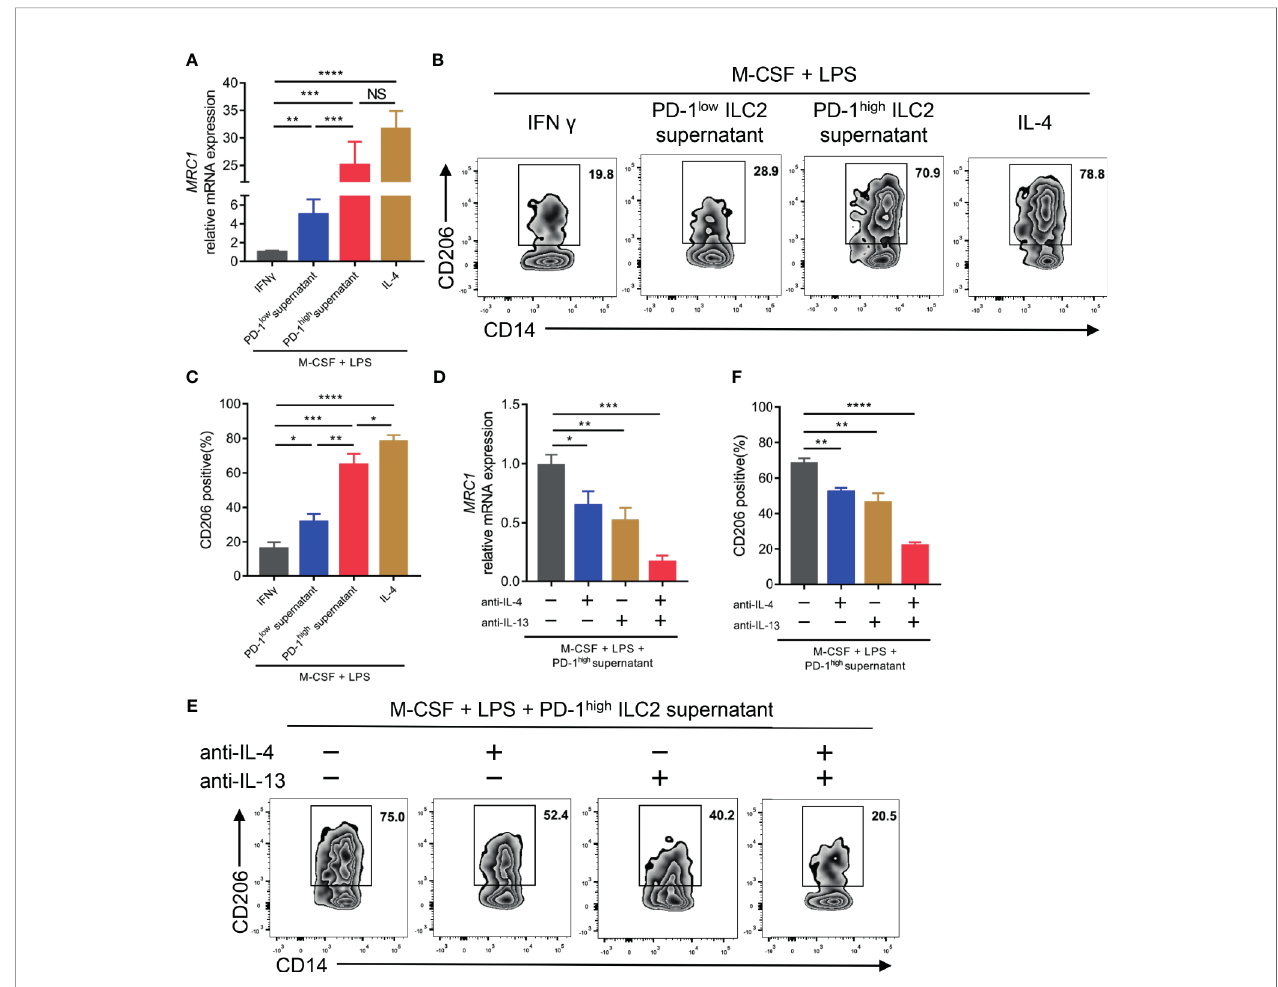
FIGURE 6 | PD-1 high ILC2s enhanced the polarization of M2-like macrophages by upregulating IL-4 and IL-13 in vitro . (A – C) Sorted CD14 + monocytes from HD PBMCs were treated with recombinant human M-CSF for seven days, and then mixed with LPS and IFN g (for M1-like macrophages) or IL-4 (for M2-like macrophages) or PD-1 high ILC2s culture supernatant or PD-1 low ILC2s culture supernatant for an additional 18 hours. The CD14 + cells were harvested for qPCR and fl ow cytometry. (A) PD-1 high ILC2 culture supernatant enhanced MRC1 (encoding CD206, a well-known M2 macrophage marker) mRNA expression compared with PD-1 low ILC2 culture supernatant treated with CD14 + cells. (B, C) The CD206 protein expression was assessed via fl ow cytometry, the representative results (B) and statistical results (C) (n=6) of which are shown. (D – F) CD14 + monocytes sorted from HD PBMCs were treated with recombinant human M-CSF for seven days and divided into four groups to which the following were added: the solute, anti-IL-4 antibody, anti-IL-13 antibody, and a combination of anti-IL-4 and anti-IL-13 antibodies, respectively. Two hours later, LPS and PD-1 high ILC2 supernatant were added to all groups and cultured for another 18 hours. (D) Anti-IL-4 and/or anti- IL-13 antibodies decreased the mRNA expression of MRC1 . (E, F) The levels of CD206 were diminished after IL-4 and/or IL-13 blockade testing by fl ow cytometry, the representative results (E) and statistical results (F) (n=5) of which are shown. NS, not signi fi cant; * P <0.05, ** P <0.01, *** P <0.001, **** P <0.0001. P values were calculated by one-way ANOVA and post hoc comparisons were performed via Tukey ’ s